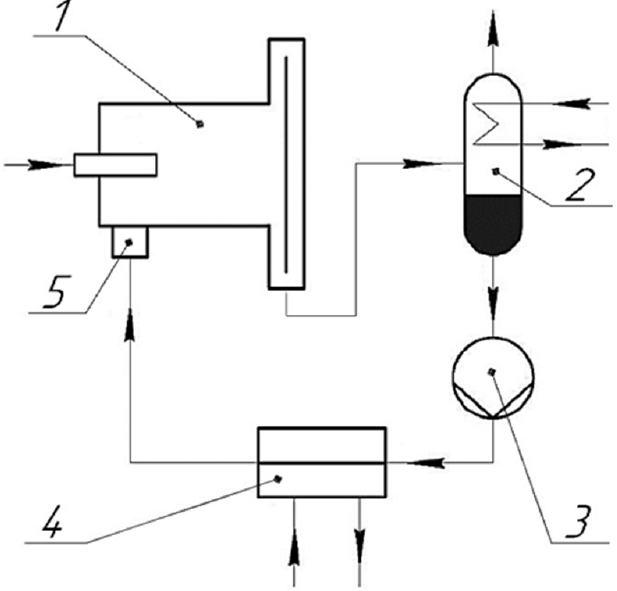
Figure 3. The design scheme of the experimental stand: 1—vortex-type liquid–steam jet apparatus; 2—separator; 3—pump; 4—heat exchanger; 5—active flow nozzle.